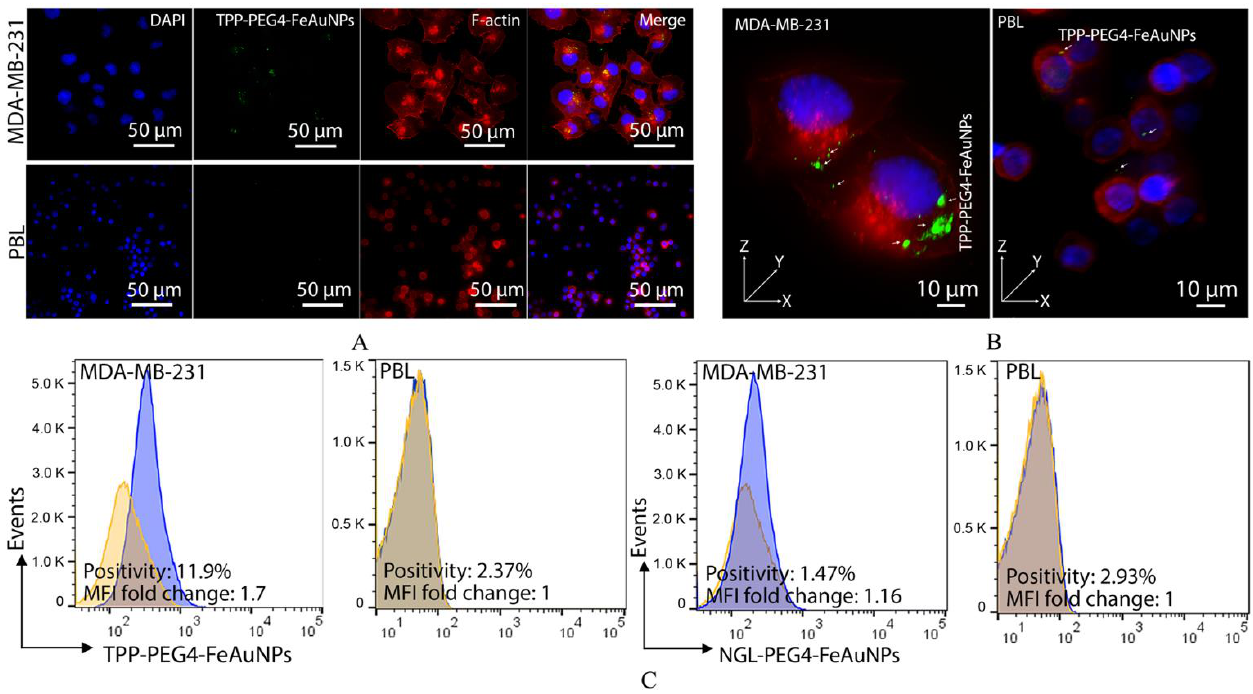
Figure 3. ( A , B ) Visualization of the specific uptake of TPP-PEG4-FeAuNPs into mHsp70-positive MDA-MB-231 tumor cells, but not into mHsp70-negative normal cells (PBL). DAPI was shown as blue, green for FITC and red for F-actin. ( B ) 3D images of the tumor (MDA-MB-231) and normal (PBL) cells were acquired by fluorescence microscopy. ( C ) Quantification of the uptake of TPP-PEG4-FeAuNPs and NGL-PEG4-FeAuNPs into mHsp70-positive tumor cells (MDA-MB-231) and normal cells (PBL) was determined by flow cytometry. On Y axis, k is equivalent to 1000. Experiments were repeated twice and representative data are presented.